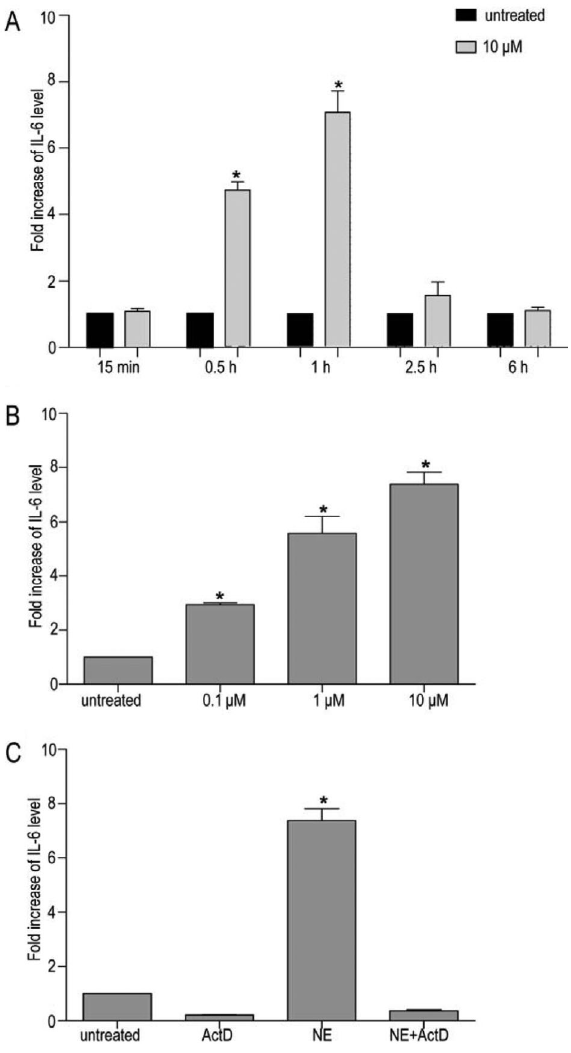
Figure 2. Norepinephrine (NE) increases IL-6 mRNA in GES-1 cells. A , Pattern of NE-stimulated IL-6 mRNA levels in GES-1 cells. Levels of mRNA in GES-1 cells were measured using real- time PCR after treatment with 10 m M NE for 15 min, 0.5 h, 1 h, 2.5 h, and 6 h. Peak expression of IL-6 mRNA was observed at 1 h after treatment and decreased thereafter. B , Dose-response pattern of NE upregulates IL-6 mRNA levels in GES-1 cells. Levels of mRNA in GES-1 cell were measured using real-time PCR after treatment with 0, 0.1, 1, and 10 m M NE for 1 h. Peak expression of IL-6 mRNA was observed after 10 m M NE treatment. C , The NE-dependent up-regulation of IL-6 mRNA levels in GES-1 cells was mainly through the stimulation of transcription. Real-time PCR assay measuring IL-6 mRNA levels in GES-1 after treatment with 5 m g/mL actinomycin D (Act D), 10 m M NE, or NE++Act D for 1 h. Data are from 2-3 independent tests with triplicates. Data are reported as mean±SE fold increase of untreated control levels. *P , 0.05, compared to untreated control